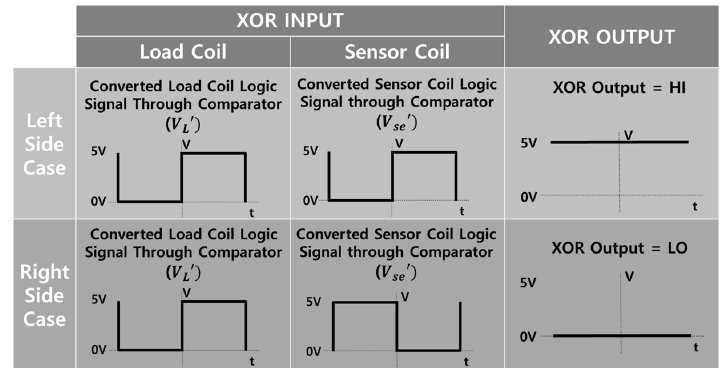
Figure 14. The XOR gate output from the converted load coil and the sensor coil logic signal inputs based on left or right side lateral misalignment.